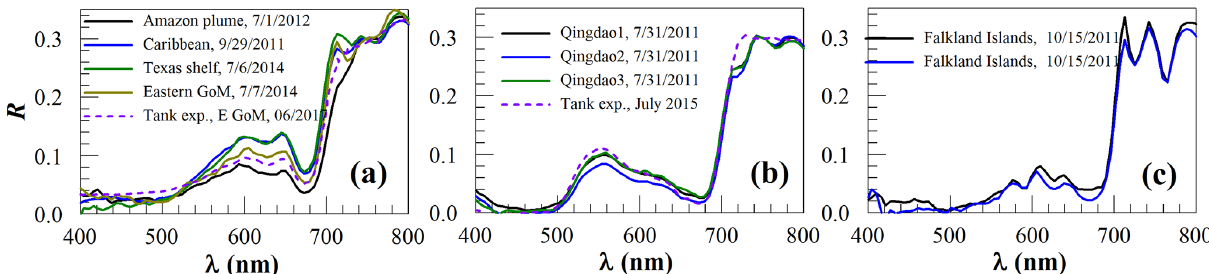
Figure 2. Surface reflectance ( R , dimensionless) of macroalgae: (a) pelagic Sargassum fluitans and S. natans , (b) Ulva prolifera , (c) kelp. The dashed lines in (a) and (b) denote R from water tank experiments of Wang et al. (2018) and Hu et al. (2017), respectively. GoM denotes the Gulf of Mexico. Where full dates are given in figures, they are formatted as month/day/year.